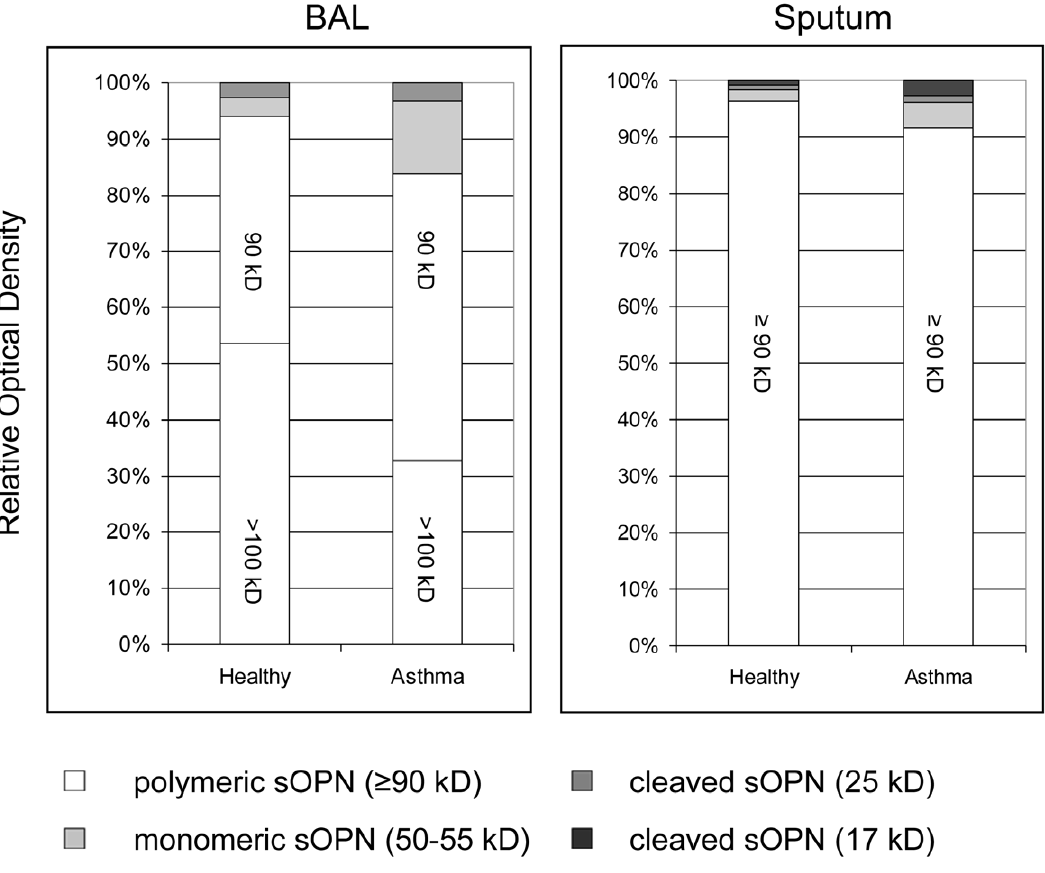
Figure 3. Secreted OPN in BAL and sputum. Relative optical density of polymeric, monomeric, and cleaved sOPN in BAL fluid and induced sputum of healthy and asthmatic subjects. White: polymeric sOPN ( $ 90 kD); light gray: monomeric sOPN (50–55 kD); dark gray: cleaved sOPN (25 kD); black: cleaved sOPN (17 kD).